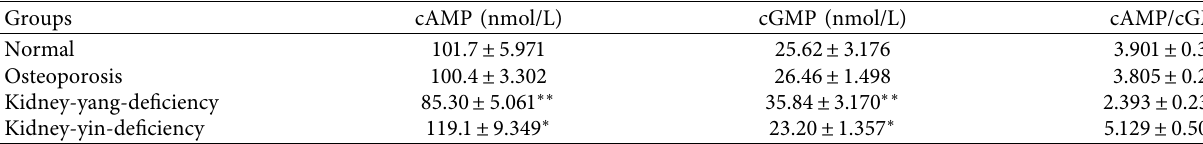
Figure 2: Pathological section of the femur in normal (a) and osteoporotic (b) rats. Table 2: Plasma concentrations of cAMP and cGMP in rats ( n � 6).